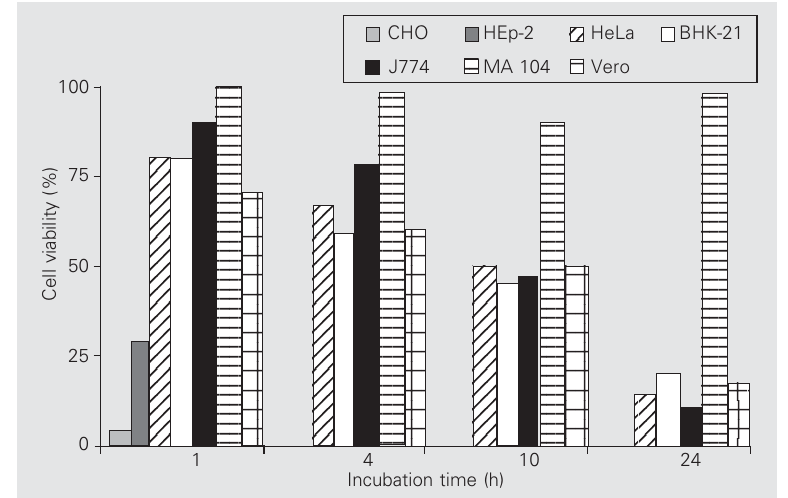
Figure 3. Response of the CHO, HEp-2, HeLa, BHK-21, Vero, MA 104 and J774 cell lines after different incubation periods with a 2 CD 50 dose (0.56 µg/ml) of purified Serratia marcescens cytotoxin. Cell viability was measured by neutral red